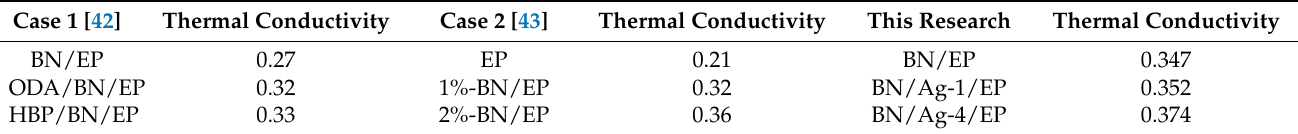
Figure 7. Thermal conductivity of BN/AgNWs/EP Composites. Table 4. Comparison of thermal conductivity data with other experiments.